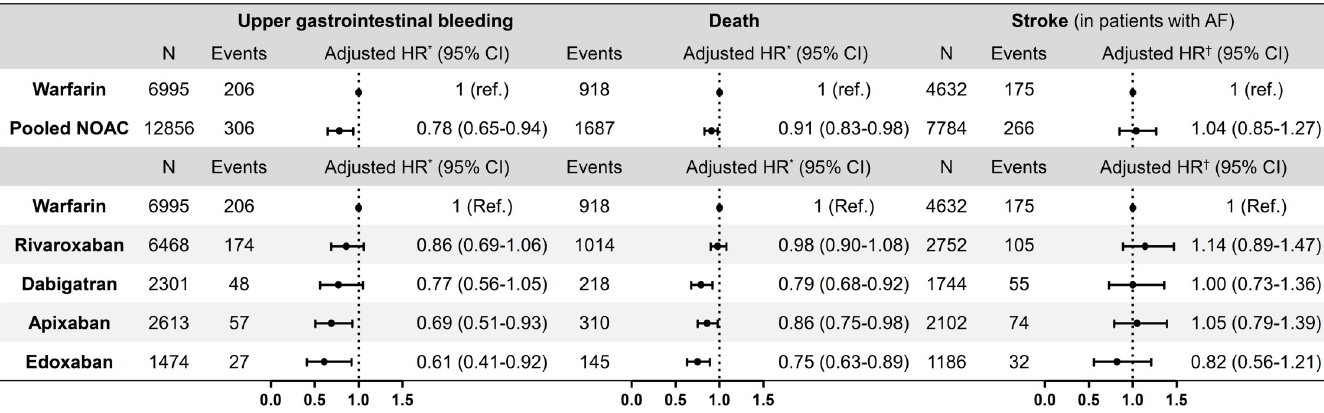
Fig 3. Differential risk of upper gastrointestinal bleeding, death, and ischemic stroke in users of warfarin and 4 NOACs. In patients on combined proton pump inhibitor and oral anticoagulant therapy, NOACs were associated with lower risk of upper gastrointestinal bleeding and mortality compared to warfarin, while there was no significant difference among the OACs in risk of stroke. � Adjusted for age, sex, atrial fibrillation, venous thromboembolism, comorbidities (hypertension, diabetes mellitus, chronic kidney disease, ischemic heart disease, heart failure, peptic ulcer disease), and concomitant use of aspirin, P2Y 12 inhibitor, and nonsteroidal anti- inflammatory drug. † Additionally adjusted for the CHA 2 DS 2 -VASc score. NOAC, non-vitamin K antagonist oral anticoagulant; AF, atrial fibrillation.